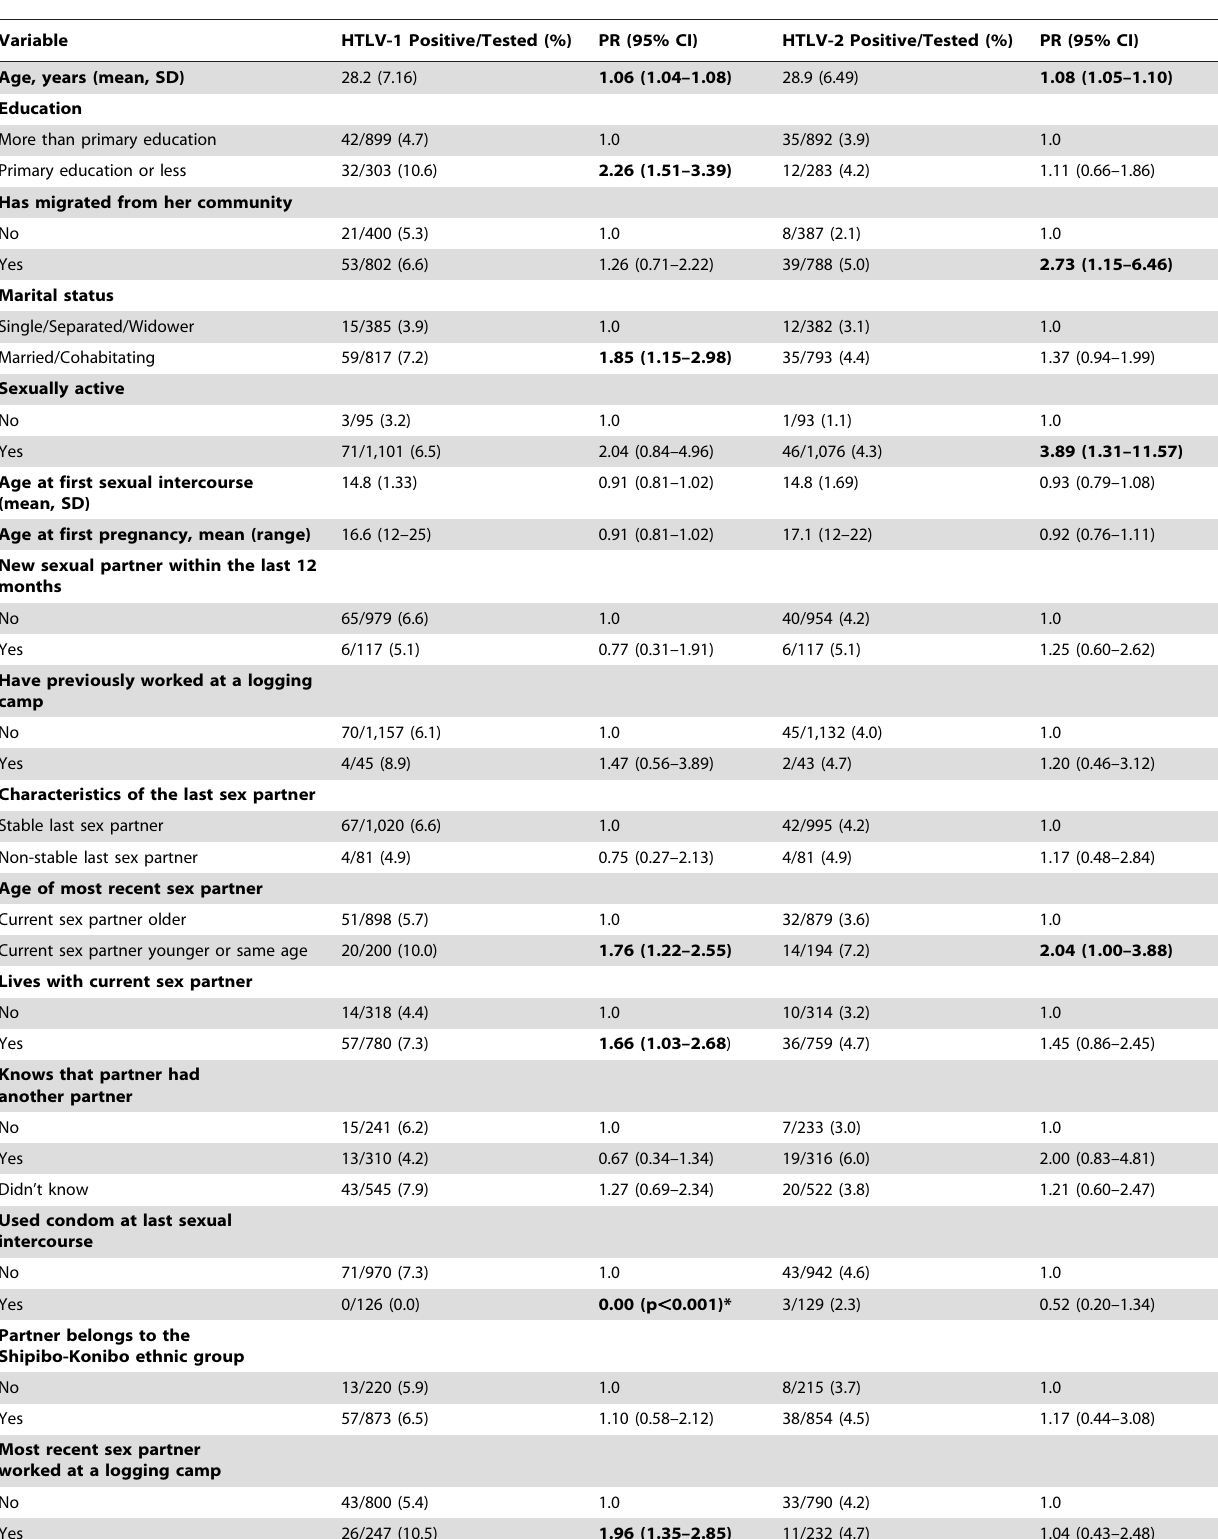
Table 1. Factors associated with human T cell lymphotropic virus type 1 (HTLV-1) and HTLV-2 infections among women from the Shipibo-Konibo ethnic